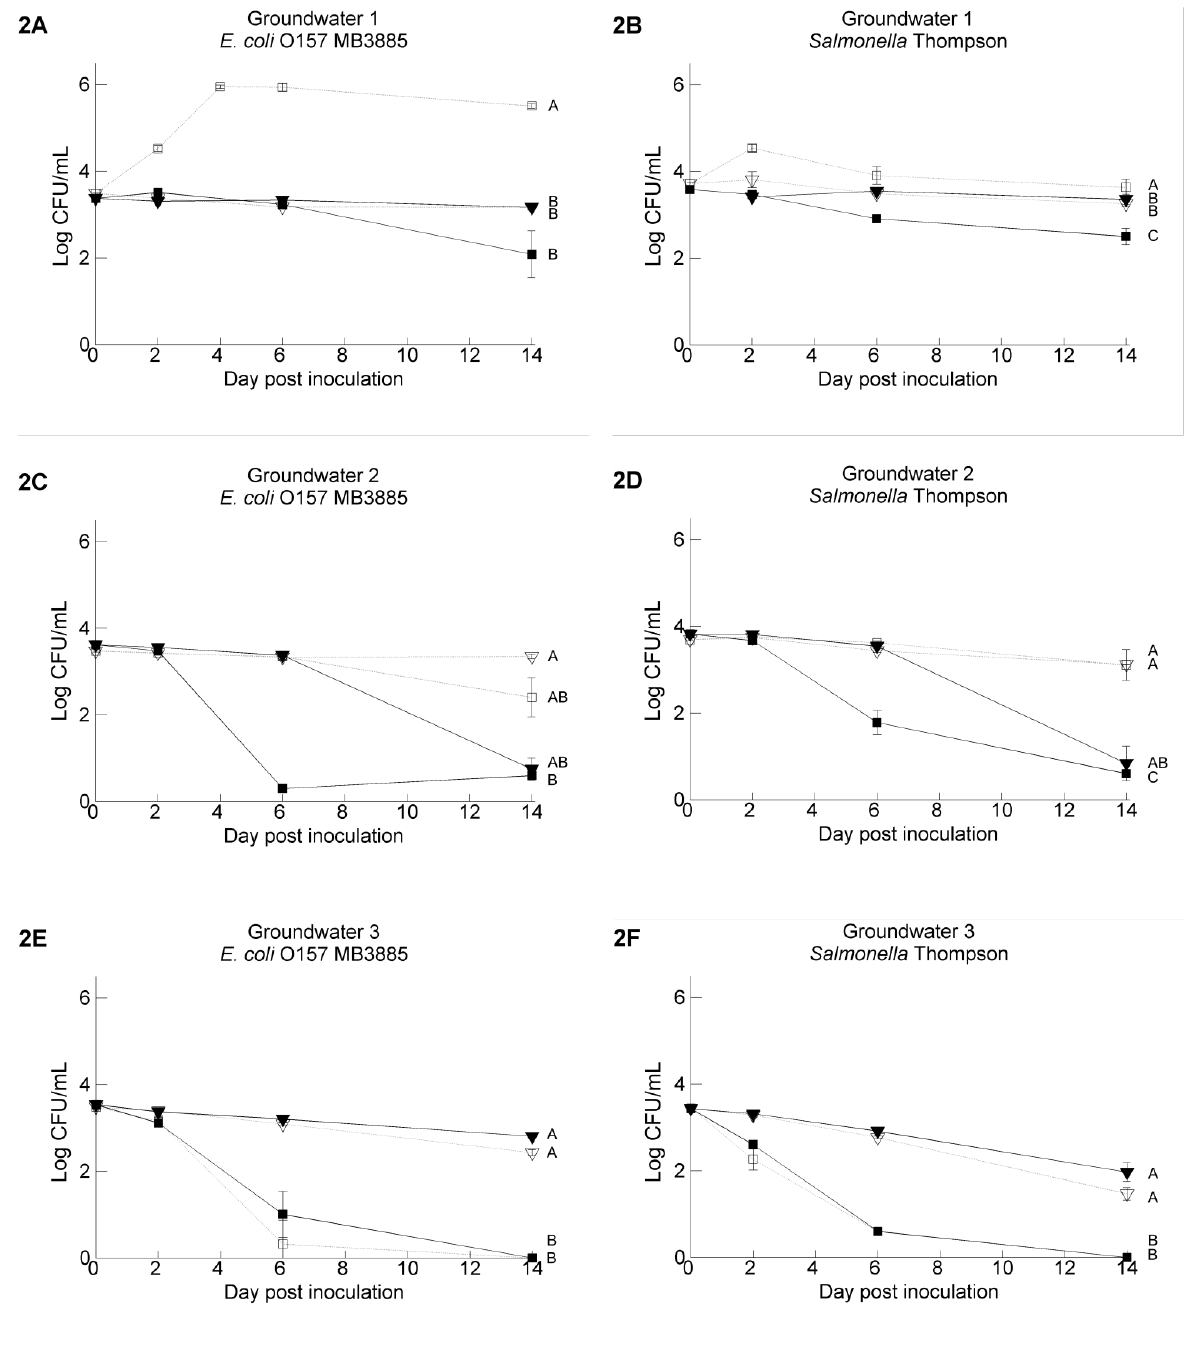
Figure 2. Survival of E. coli O157:H7 MB3885 ( left ) and Salmonella Thompson RM1987N ( right ) in three ground water samples with the following treatments: untreated water samples stored at 4 °C (full line,  ), filter sterilized water samples stored at 4 °C (dashed line,  ), untreated water samples stored at 20 °C (full line,  ), filter sterilized water samples stored at 20 °C (dashed line,  ). The data show the mean of three analyzed vials and are calculated from the log transformed values of the pathogen population size. Error bars indicate standard deviations. Different letters indicate significant difference ( p < 0.05) between means according to negative binomial